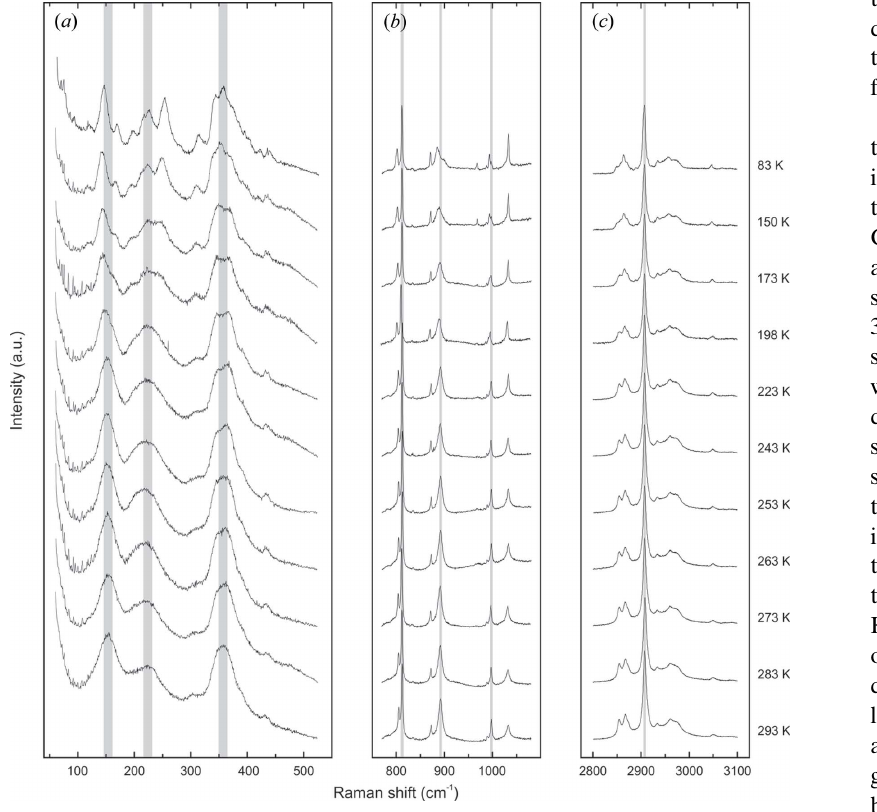
Figure 2 Selected ranges of the Raman spectra between 293 and 83 K. ( a ) SiO 2 -framework vibrations (60– 500 cm (cid:4) 1 ), ( b ) C—C stretching vibrations (770–1080 cm (cid:4) 1 ), ( c ) C—H stretching vibrations (2800– 3100 cm (cid:4) 1